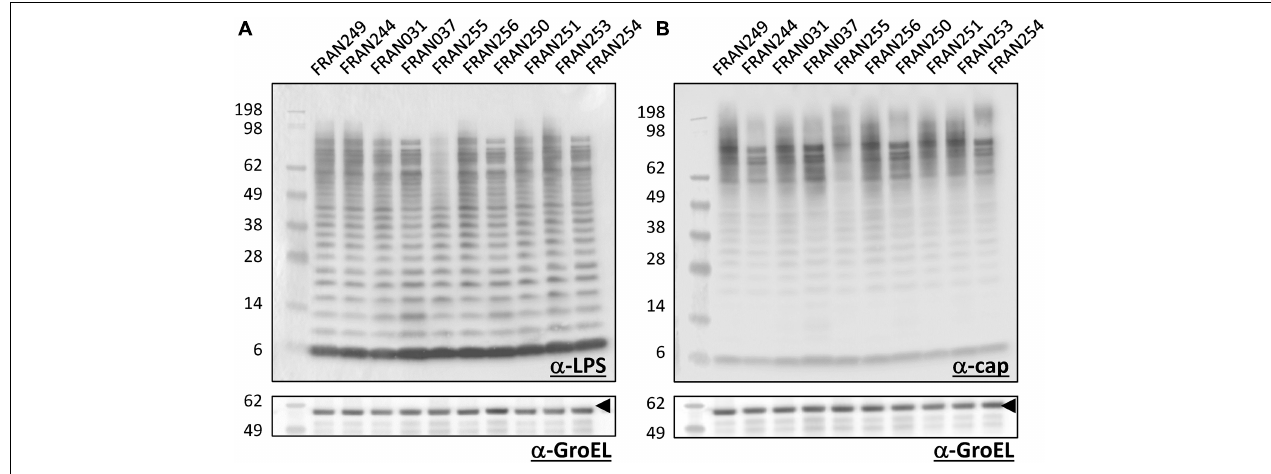
FIGURE 8 | Western blot analysis of F. tularensis strains. Pellets of the 10 F. tularensis strains were lysed. Extracts were run on SDS-PAGE gels at equal concentrations and blotted with either a monoclonal antibody to the O-antigen of LPS (A) or capsule (B) of F. tularensis . Equal loading of sample material was demonstrated when blotting the extracts with a polyclonal antibody directed against the GroEL protein (indicated by the arrowheads). Molecular masses are indicated on the left in